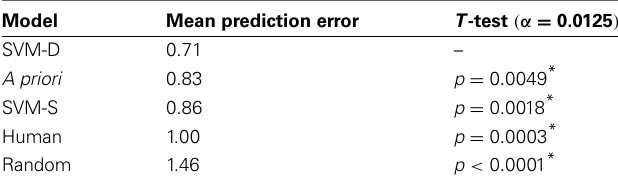
Table 5 | The updated comparisons of the baseline models to the new SVM-D model with a total of 42 features, which are listed in Tables 1,